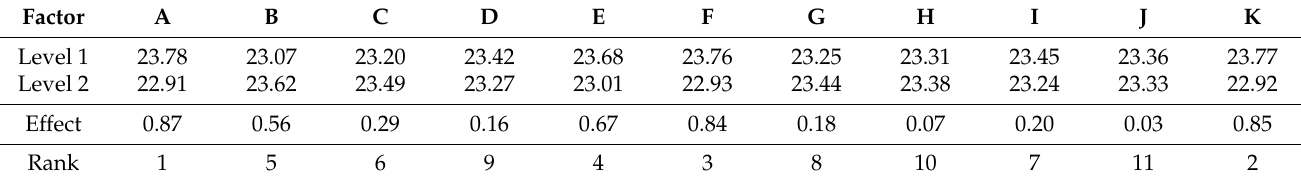
Table 4. Factor response table for the S/N ratios of the L 12 (2 11 ) experiment.